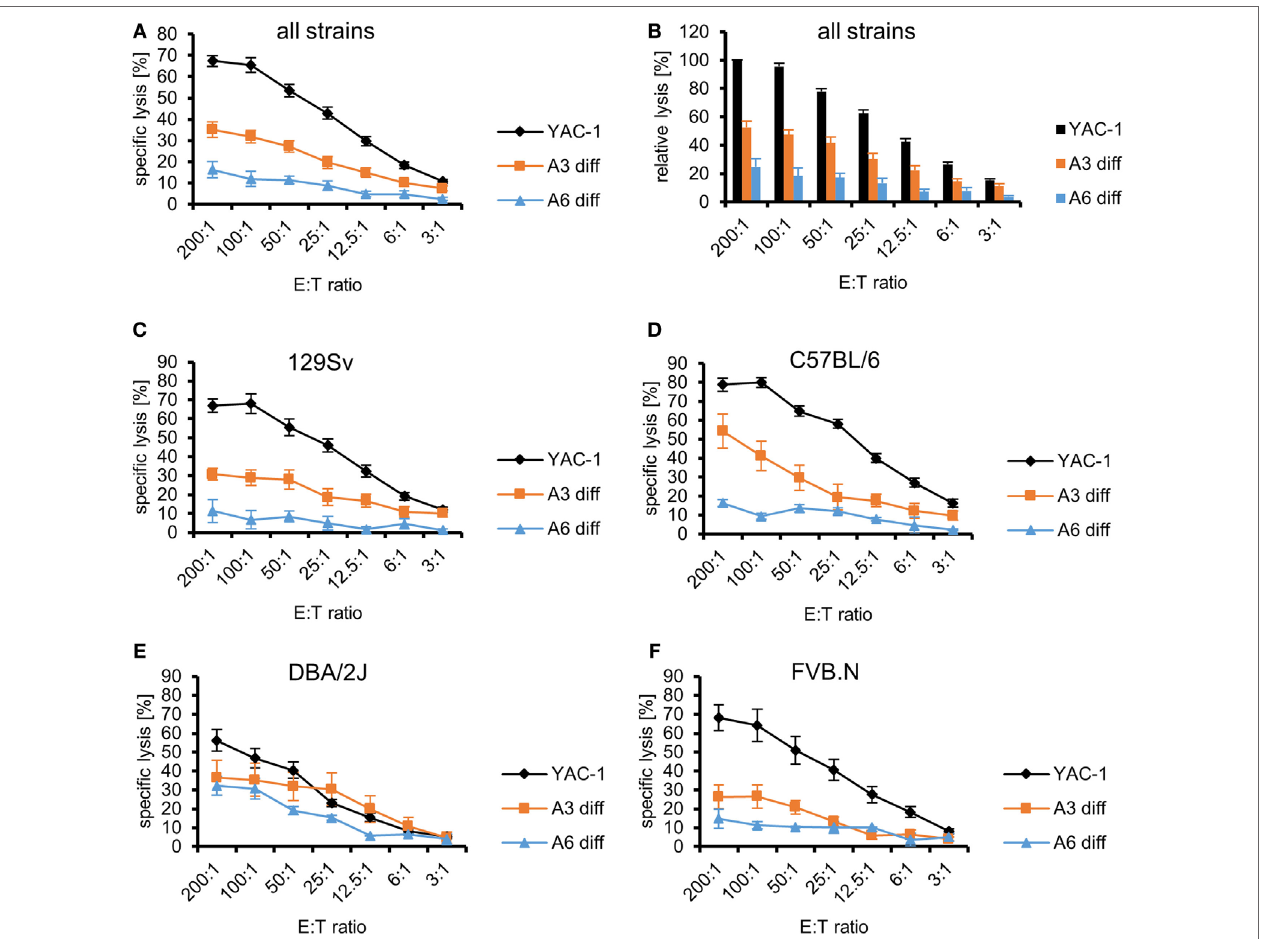
FigUre 4 | Comparison of the killing of in vitro -differentiated A3 and A6 cells and YAC-1 control cells by lymphokine-activated killer (LAK) cells of four mouse strains. (a) A summary of means of specific lysis and SEM is shown as determined by 51 Cr-release assays of the three target cell lines YAC-1 ( n = 28), parthenogenetic stem cell (PSC) A3 ( n = 16), and PSC A6 ( n = 12) using LAK cells from four mouse strains (129Sv, n = 12; C57BL/6, n = 5; DBA/2J, n = 5; FVB.N, n = 6). (B) The data are shown as relative lysis calculated by setting the specific lysis of YAC-1 cells at the highest effector to target (E:T) ratio (200:1) in individual experiments to 100% and adjusting the relative lysis at lower E:T ratios and of other target cells accordingly. (c) Summary of means of specific lysis and SEM by LAK cells derived from 129Sv mice ( n = 12) of YAC-1 ( n = 12), differentiated A3 ( n = 6), and differentiated A6 cells ( n = 6). (D) Summary of means of specific lysis and SEM by LAK cells derived from C57BL/6 mice ( n = 5) of YAC-1 ( n = 5), differentiated A3 ( n = 3), and differentiated A6 cells ( n = 2). (e) Summary of means of specific lysis and SEM by LAK cells derived from DBA/2J mice ( n = 5) of YAC-1 ( n = 5), differentiated A3 ( n = 3), and differentiated A6 cells ( n = 2). (F) Summary of means of specific lysis and SEM by LAK cells derived from FVB.N mice ( n = 6) of YAC-1 ( n = 6), differentiated A3 ( n = 4), and differentiated A6 cells ( n =